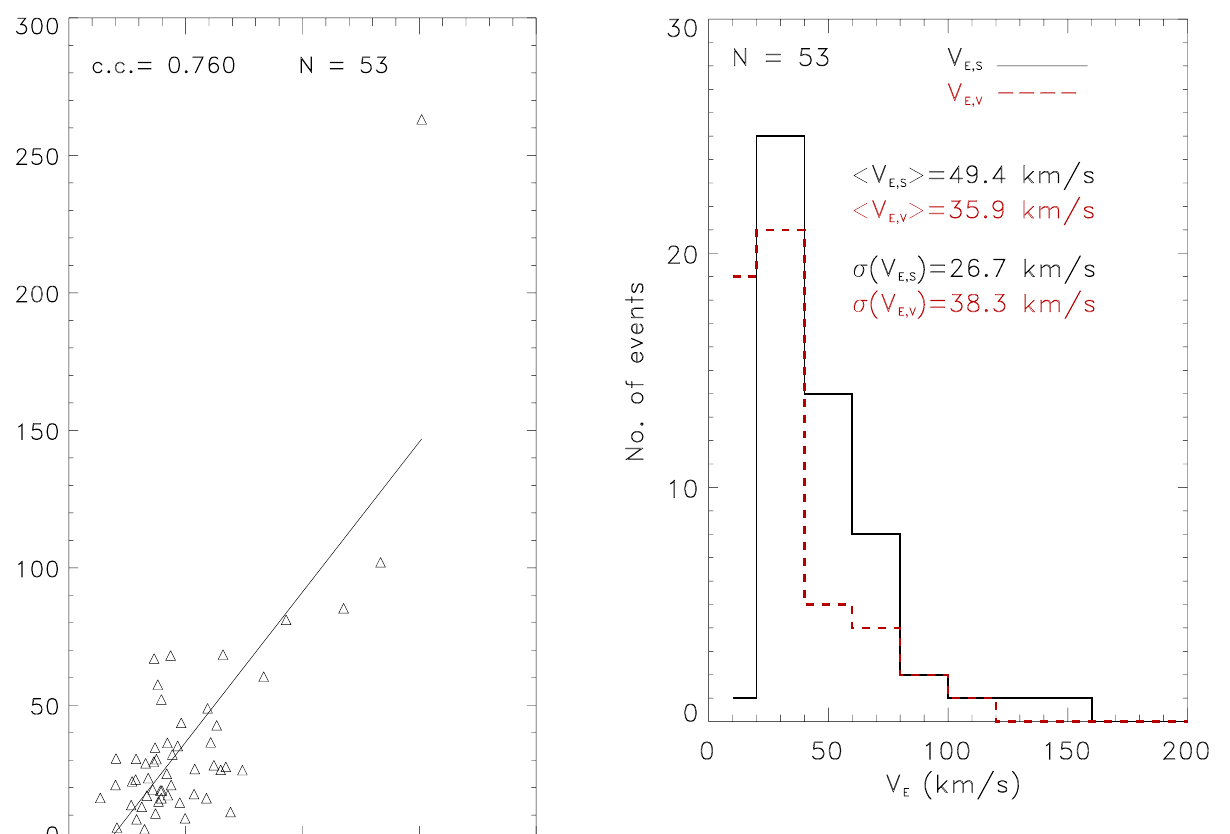
Fig. 5. Histograms of the values derived for V E,S (black) and V E,V (in red) based on Eqs. (5) and (8), respectively, i.e. where the latter is based on the actual boundary values of V Z of the MCs. The peaks for both are at 30km/s for bucket widths of 20km/s and the averages and standard deviations ( σ) are shown for the two sets. (Note that there is one value of V E,V of 263km/s that occurs off-scale and therefore is not